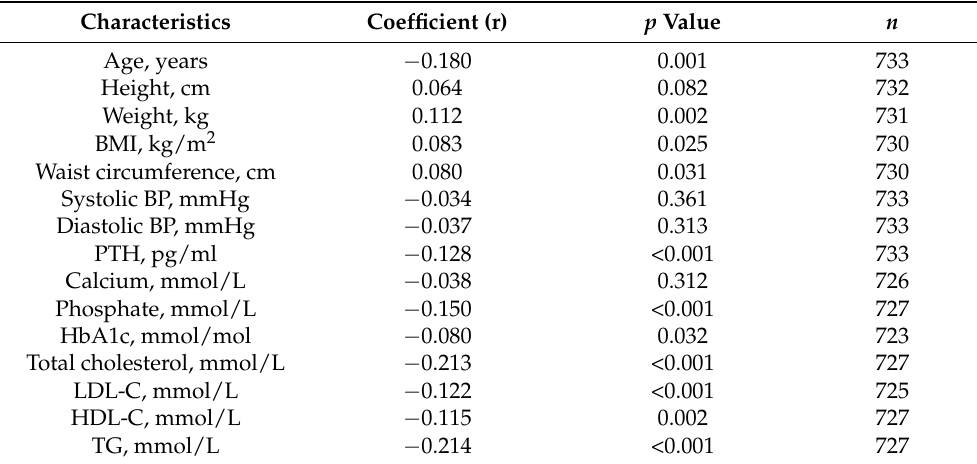
Table 4. Correlation between serum 25(OH)D and anthropometric measurements, blood pressure and biochemical parameters in the study population.